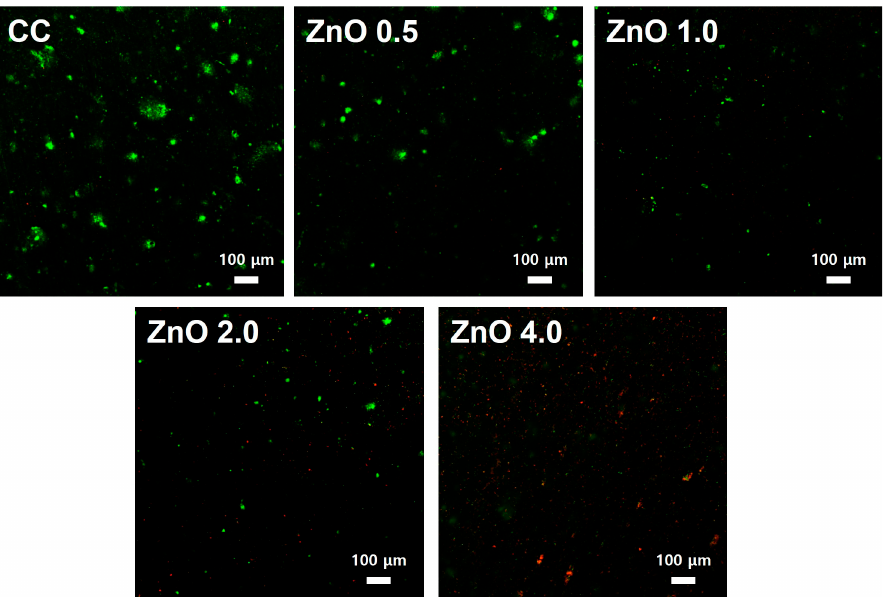
Figure 5. Bacterial viability images of S. mutans attached on the experimental material surface with/without ZnO NPs.